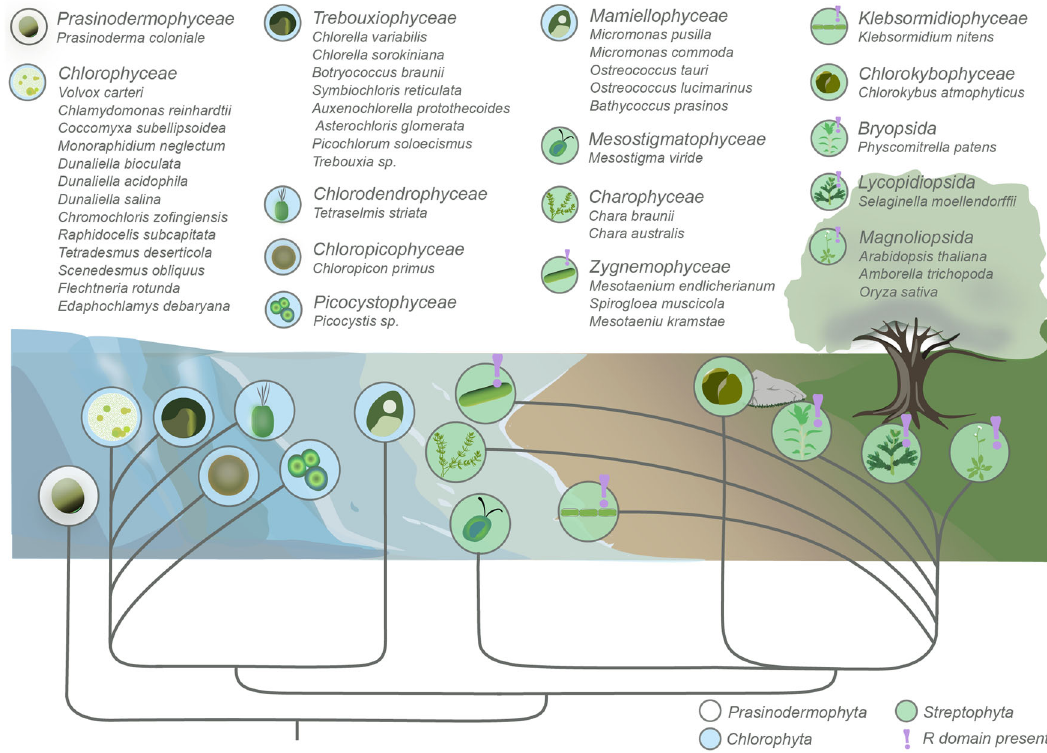
Fig. 1 The R domain of the plant plasma membrane H + -ATPase appeared in the immediate streptophyte predecessors of land plants. The fi gure shows the analyzed representative species within different classes from Prasinodermophyta, Chlorophyta, and Streptophyta. The drawing illustrates the most typical habitat of the different classes: water, water and soil or soil. Purple exclamation marks indicate the presence of the plant PM H + -ATPase R domain. The fi gure is adapted from Cheng et al. (2019) 60